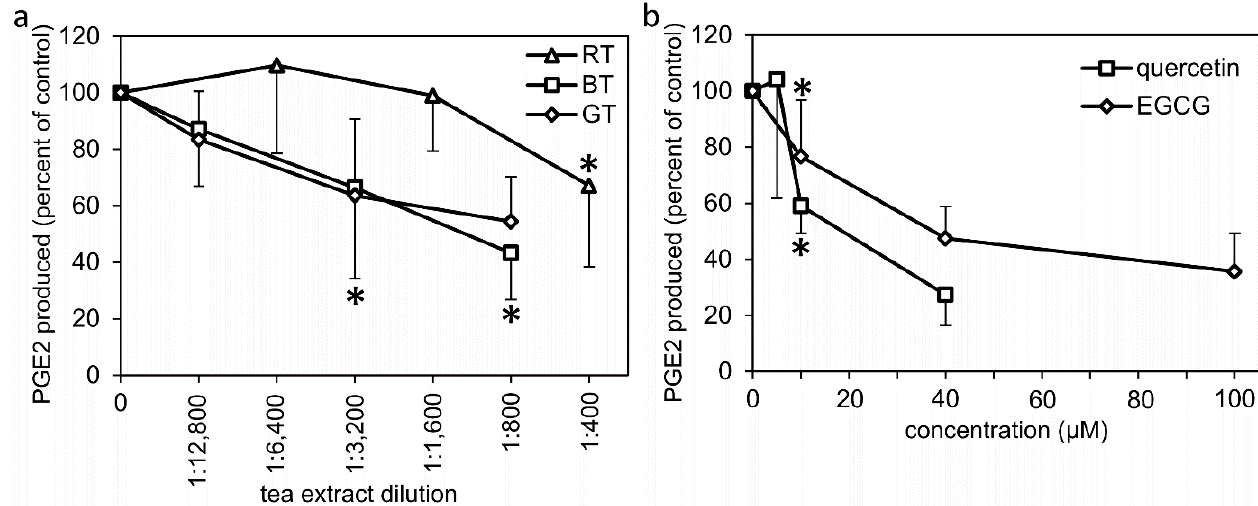
Figure 4. Cell-free assay for the combined enzymatic activity of COX and PGES to convert arachidonic acid into PGE2. A 1700 × g cell lysate supernatant from the LPS-treated monocytes was used as the enzyme source and preincubated for 15 min with ( a ) tea extracts; ( b ) EGCG or quercetin. The reaction was initiated by addition of 0.5 µM arachidonic acid and was allowed to proceed for 30 min at 37 ˚ C, followed by determination of PGE2 formation with an enzyme immunoassay. Results for each individual data point represent the mean value ± SD of 5–6 independent experiments and are expressed as percent of vehicle-treated control (PBS or DMSO). * denotes the highest dilution/lowest concentration mediating a significant inhibition ( p < 0.05). BT: black tea extract, GT: green tea extract, RT: Rooibos tea extract, EGCG: epigallocatechin gallate.